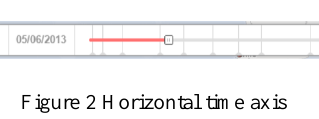
Figure 2 Horizontal time axis